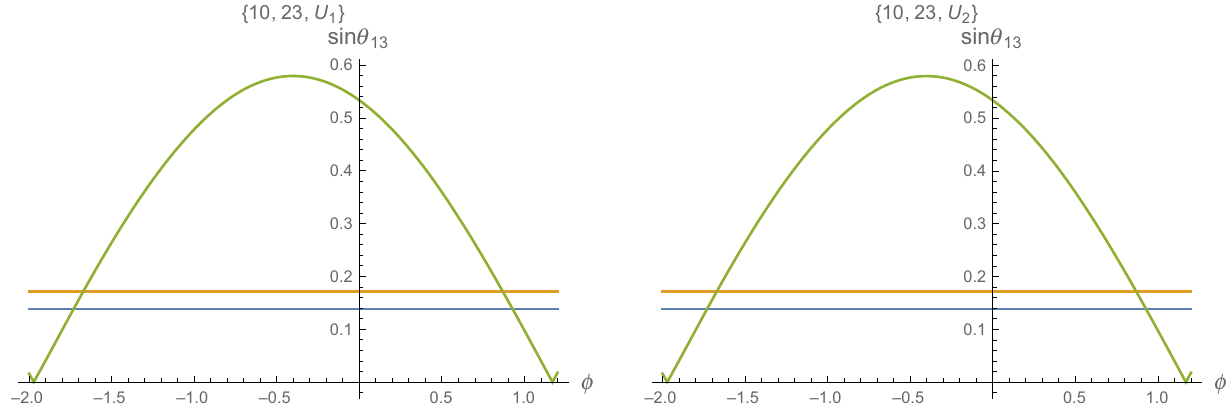
Fig. 3 Plots show the experimentally compatible range of sin θ 13 as a function of ϕ , for example 3 involving PSL 2 ( 7 ) elements of order 7. Orange and blue lines define the experimental